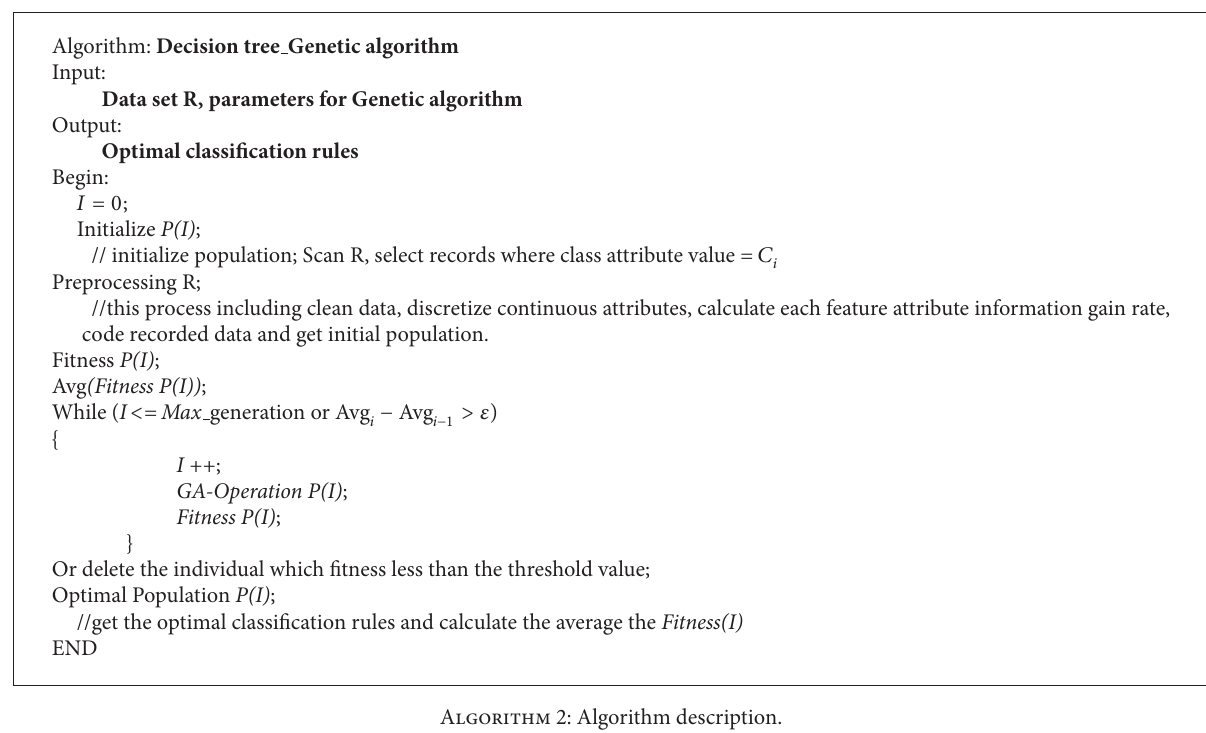
Algorithm 2: Algorithm description.